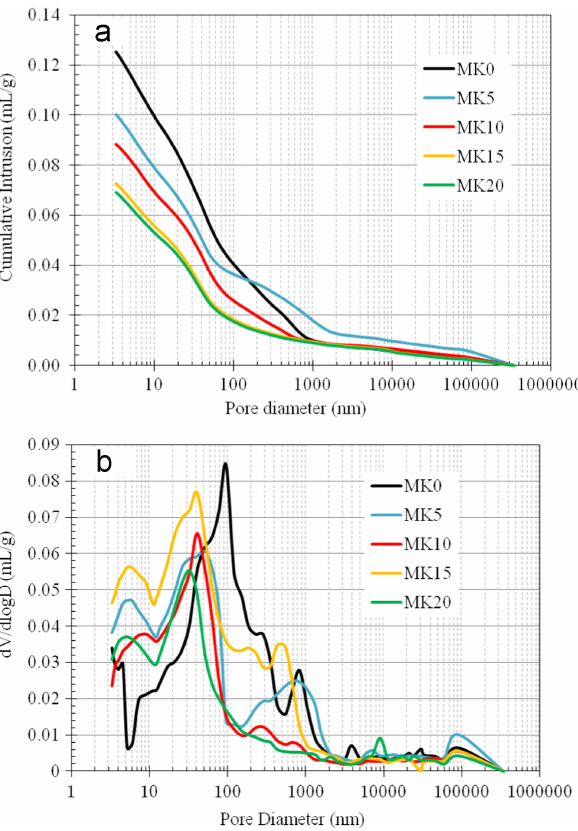
Figure 13: The porosity and pore size distribution of geopolymer incorporating various content of metakaolin after 180 days of expo- sure [77]